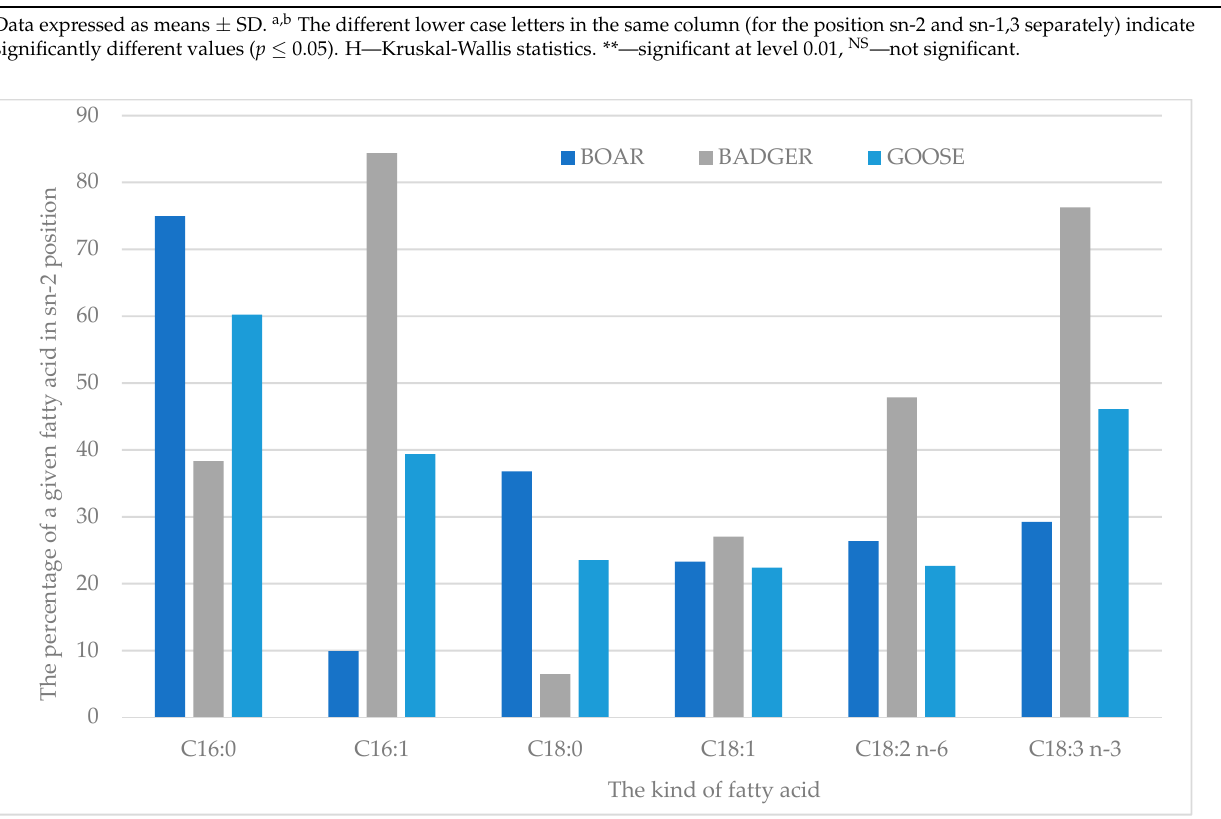
Figure 1. The percentage of a given fatty acid in internal position of boar, badger and wild goose fats, expressed as the relative fatty acid [(sn-2 fatty acid × 100%)/(3 × total fatty acid in TAGs)].